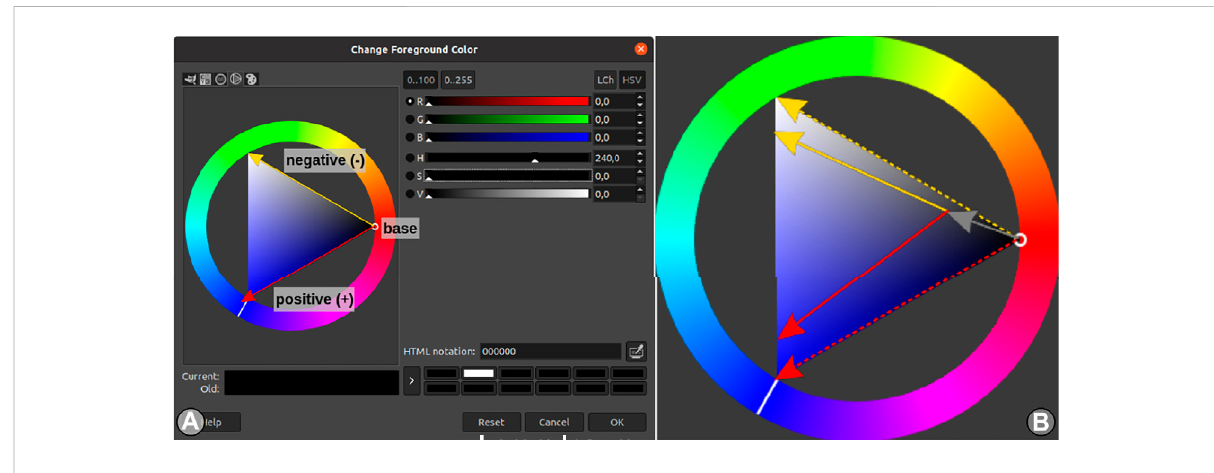
FIGURE 2 Illustrationofthesaturation-andluminance-modulatedcolourmappingattheexampleofmode2(i.e., H 180 )in (A) ,anditsbase-shiftedformfor a more print-compliant base (B)